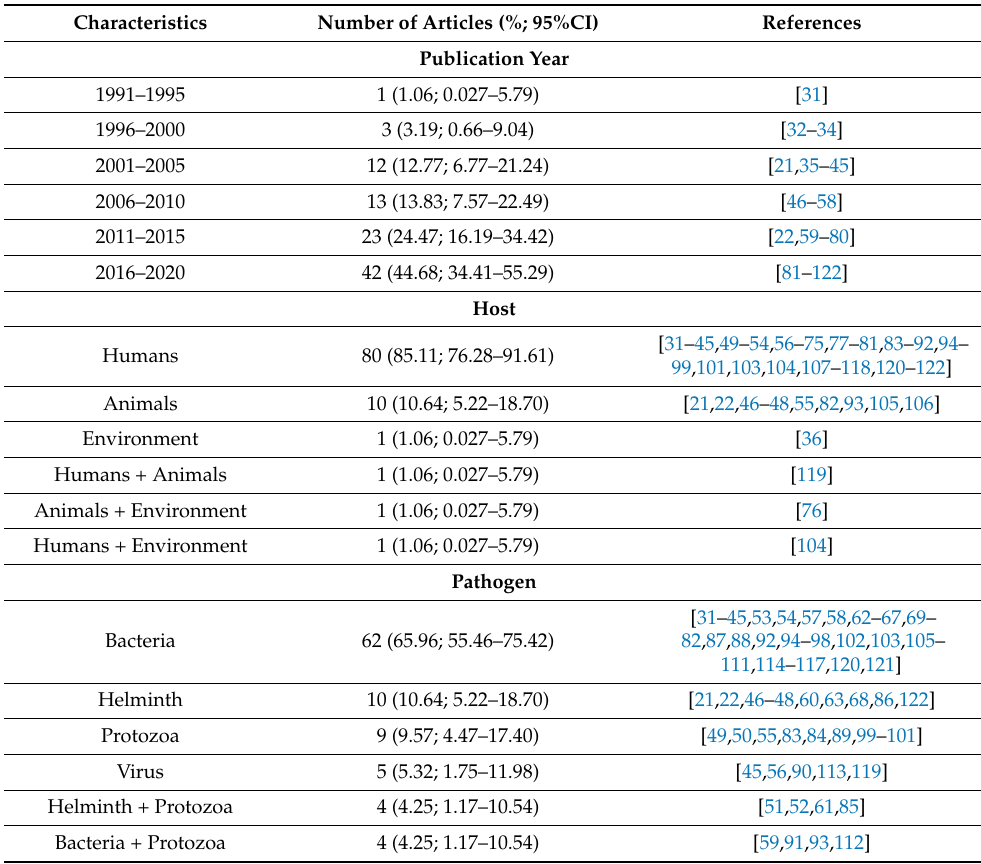
Table 1. Characteristics of the reviewed